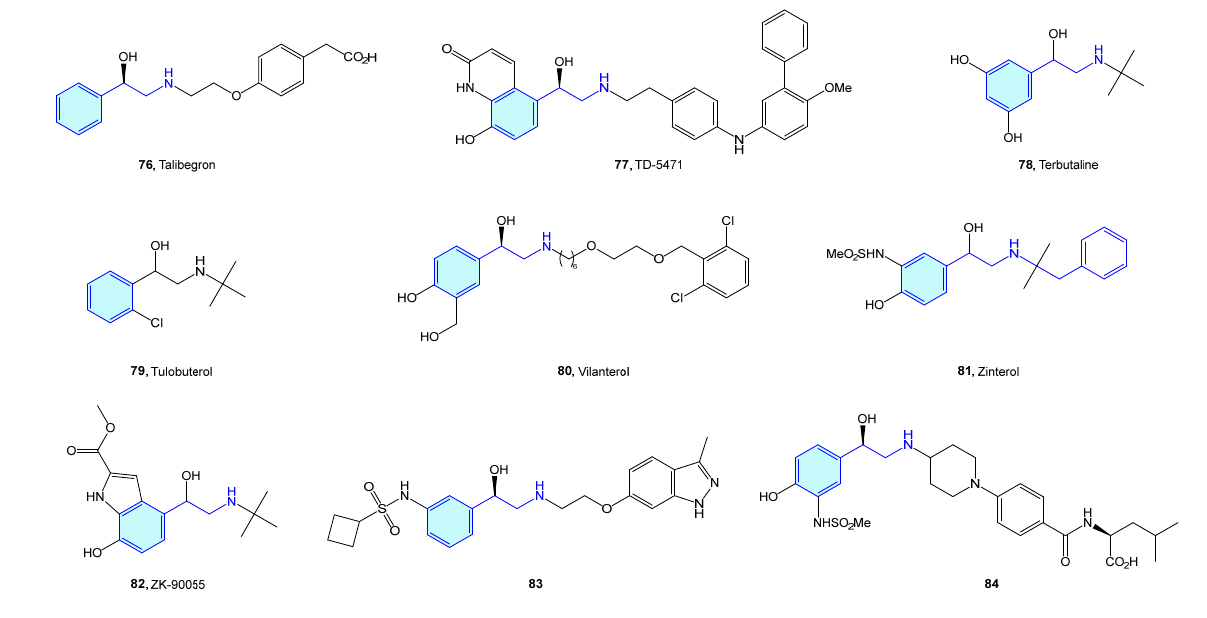
Figure 6. (cont.). 2-Phenylethyl-based β -adrenergic medicinal chemistry leads.